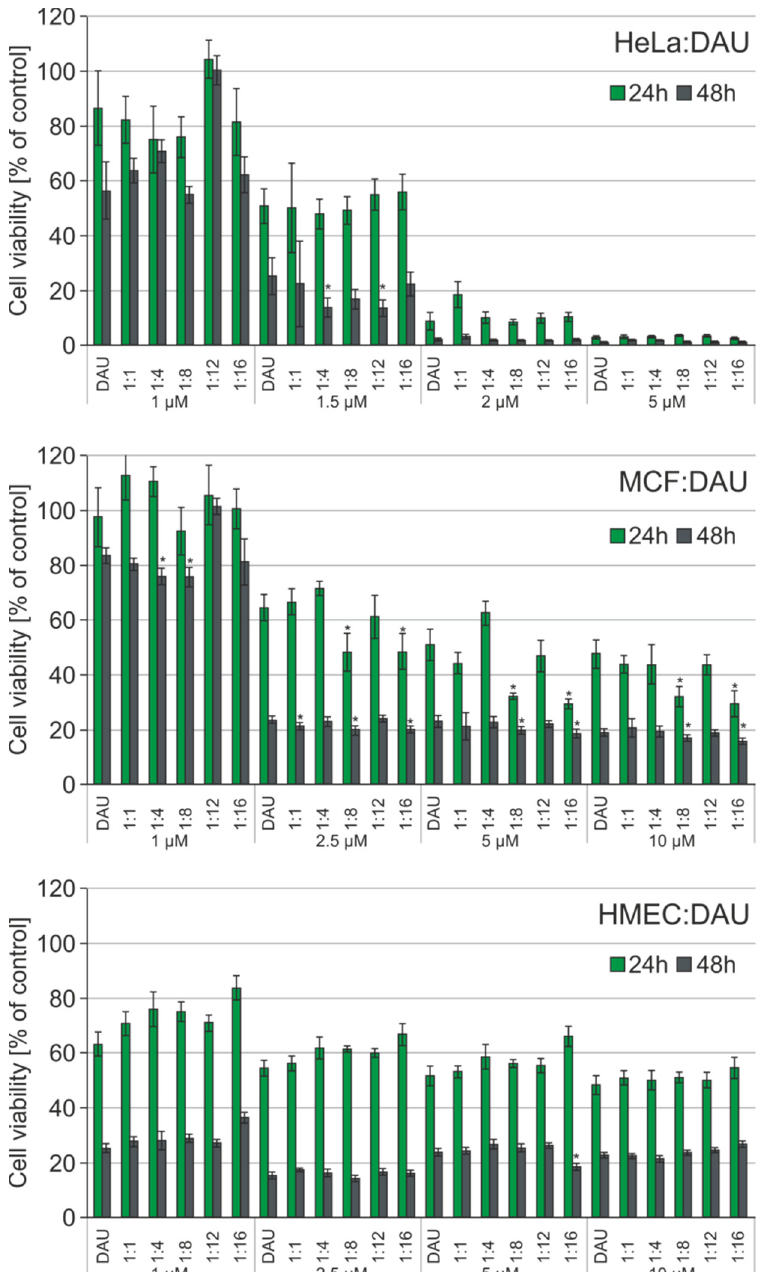
Figure 7. The influence of daunorubicin (DAU) and polyhedral oligosilsesquioxanes (POSS) complexes at different molar ratios on cell viability of human cervical cancer endothelial (HeLa), human breast adenocarcinoma (MCF-7), and non-cancer microvascular endothelial (HMEC-1) cells. POSS systems are found to be non-toxic [7]. Data are presented as a percentage of control (untreated cells) standard deviation (SD); * p < 0.05 (statistical significance between DAU and POSS:DAU complexes).